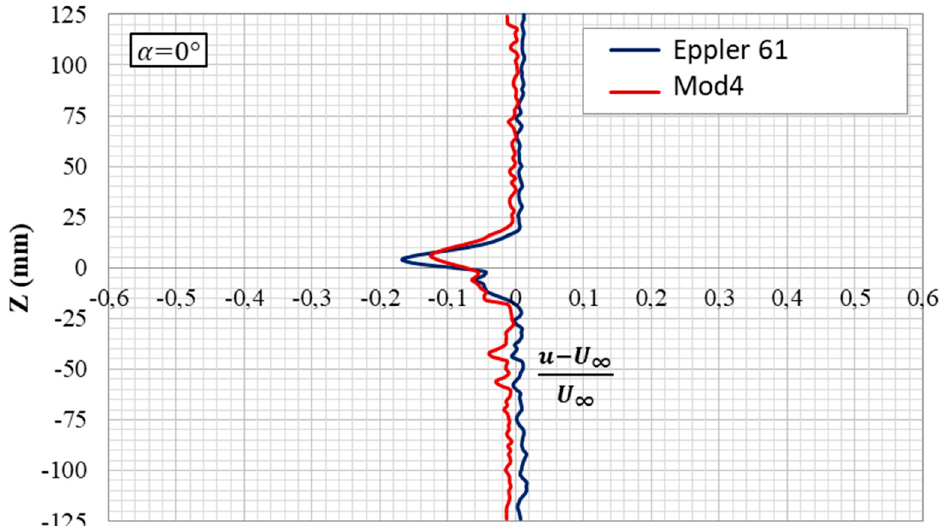
Figure 13. Velocity profile in the wake in Section S 2 .